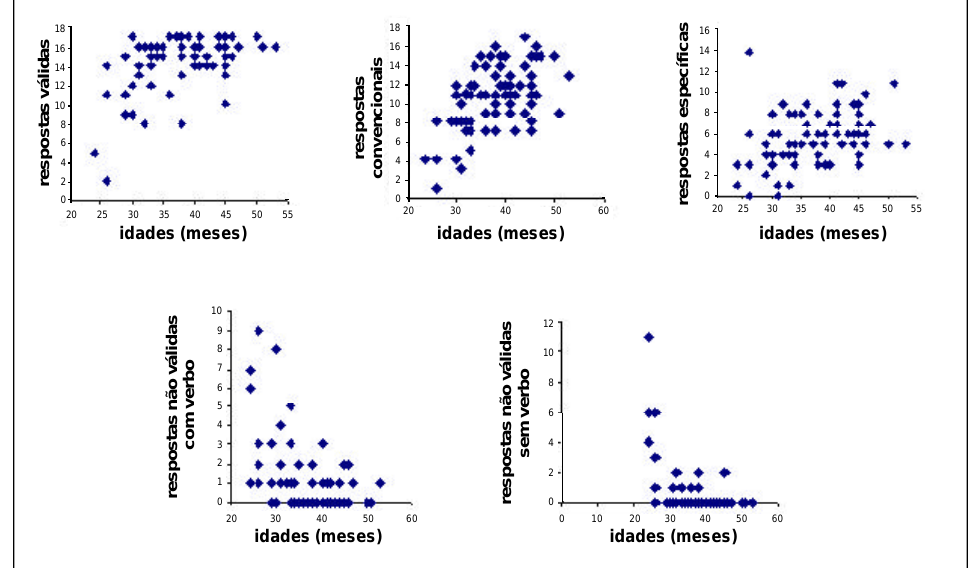
Figura 3 . Correlações entre idade medida em número de meses e respostas válidas, convencionais, verbos específicos, respostas não válidas com verbo e não válidas sem verbo.